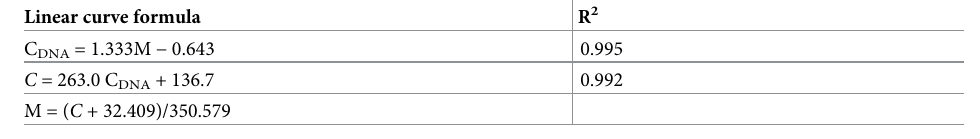
Table 5. Establishment of cassava dose response curve. Linear curve